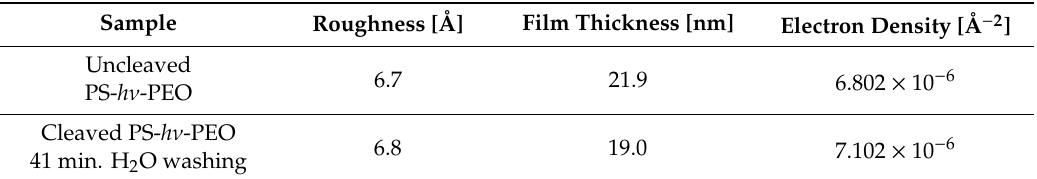
Table 1. X-ray reflectivity (XRR) data obtained from the measured curve for PS- h ν -PEO thin film in Figure 1a,b. The polymer film was cleaved for 1 h with UV and immersed for 41 min. in ultra-pure water.